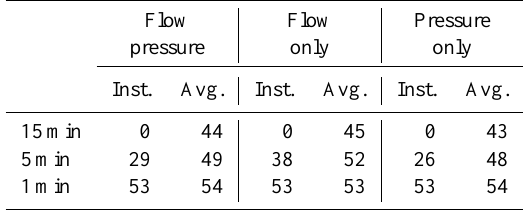
Table 1. Summary of average improvement in detection times (min- utes) over multiple instruments relative to 15min instantaneous data in each case (Mounce et al.,